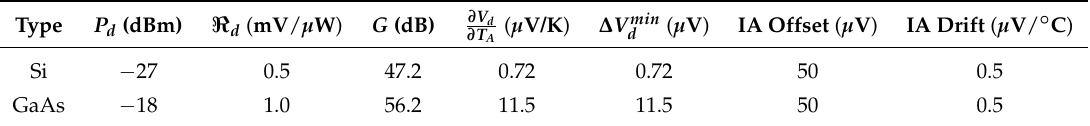
Table 7. Radiometer gain and